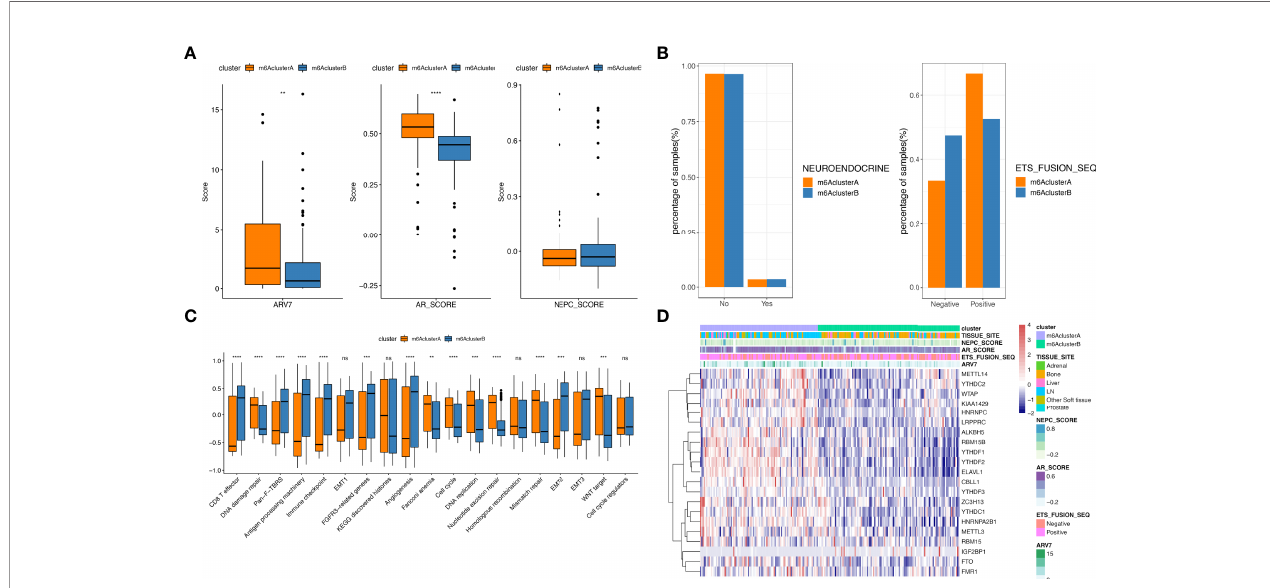
FIGURE 3 | Comparison analysis among m6A clusters. (A) The distribution of ARV7 (left), ARscore (middle) and NEPCscore (right) between the two m6A clusters; (B) The prognostic differences between the two m6A clusters; (C) Results for GSVA analysis of prad_su2c_2019 cohorts; (D) The expression of m6A regulator genes in two m6A clusters extracted from prad_su2c_2019 cohorts. ns represents P > 0.05, **P ≤ 0.01, ***P ≤ 0.001, ****P ≤